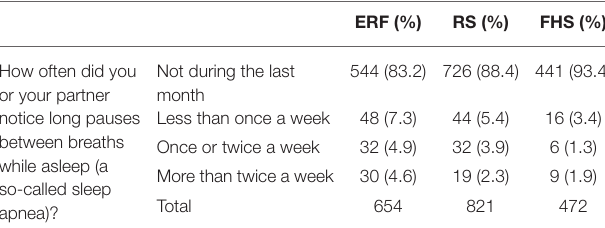
TABLE 2 | Answers to the sleep apnea question for the discovery and replication